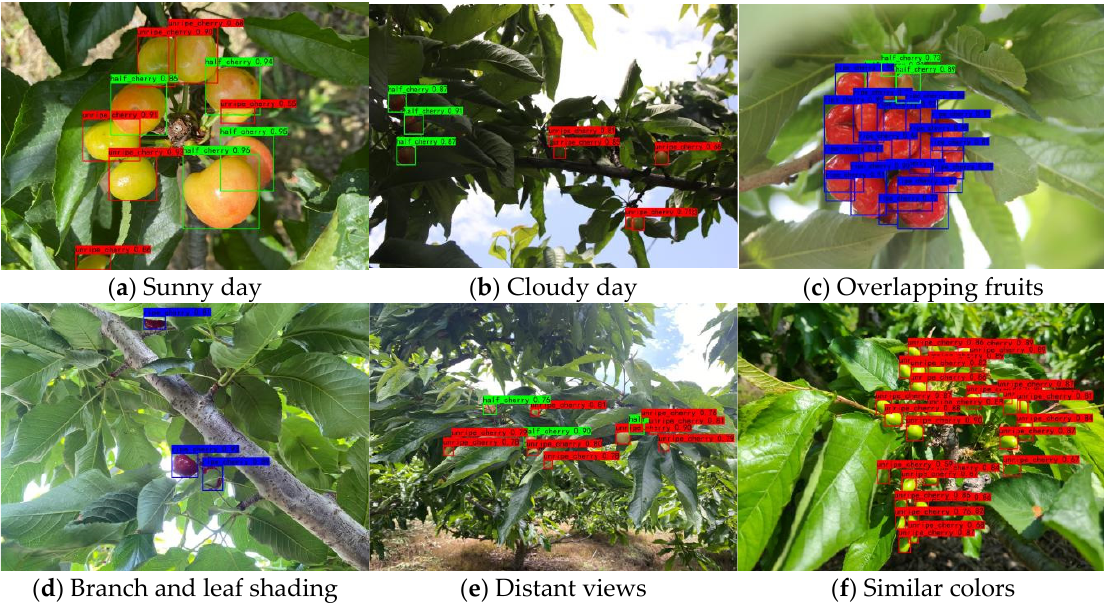
Figure 9. Effectiveness of YOLOX-EIoU-CBAM for the detection of sweet cherry fruit ripeness categories in complex orchard environments (( a ) sunny day. ( b ) Cloudy day. ( c ) Overlapping fruits. ( d ) Branch and leaf shading. ( e ) Distant views. ( f ) Similar colors).